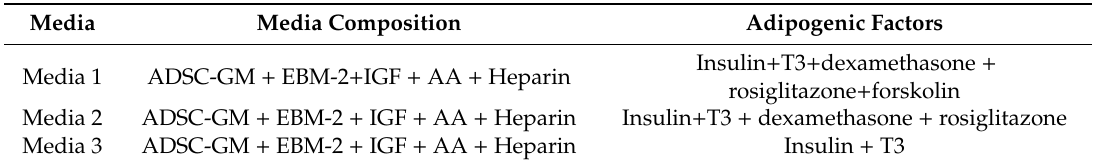
Table 3. Media groups for the screening of pro-adipogenic factors.